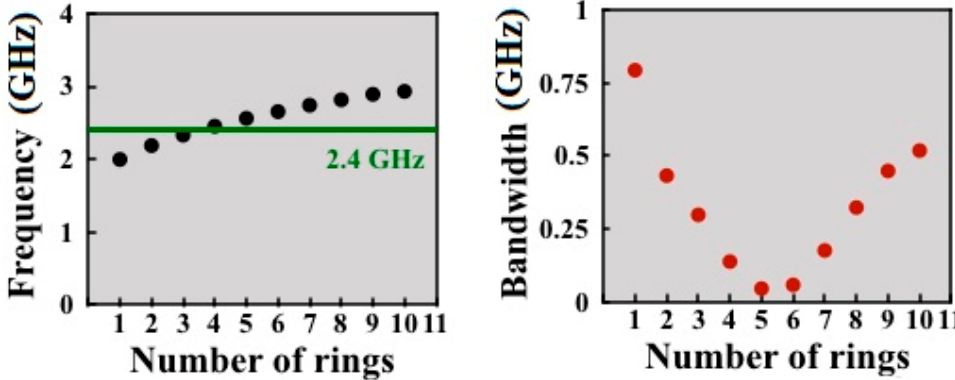
Figure 3. ( Left ) Relationship between the concentric SRRs with the bandwidth covered by the E sensor; central frequency is indicated by the 2.4 GHz green line. ( Right ) Bandwidth measured for the tested cases.